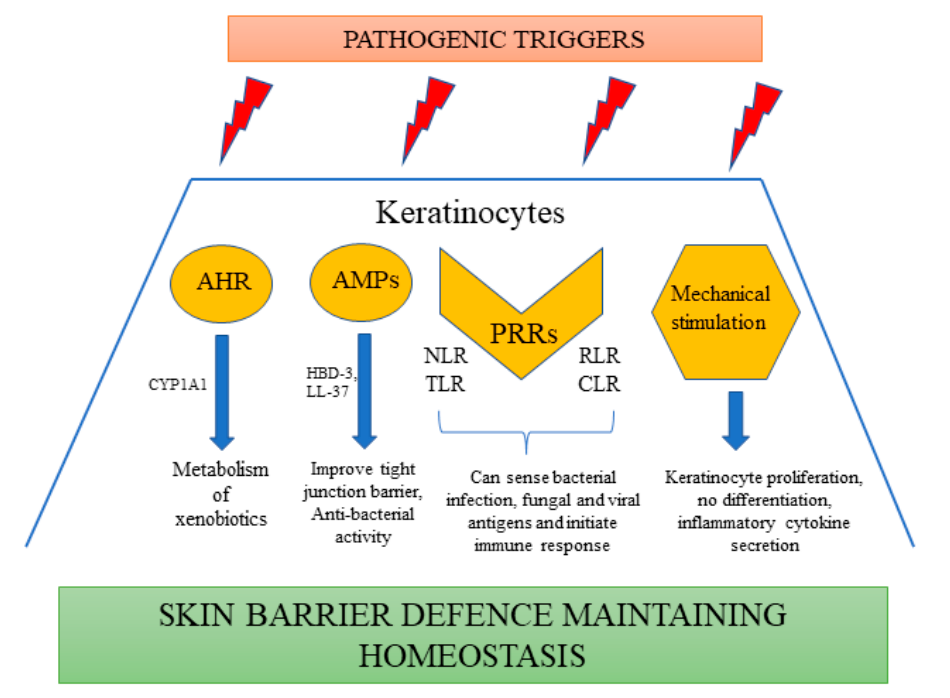
Figure 1. Keratinocytes as a part of skin immune defense.